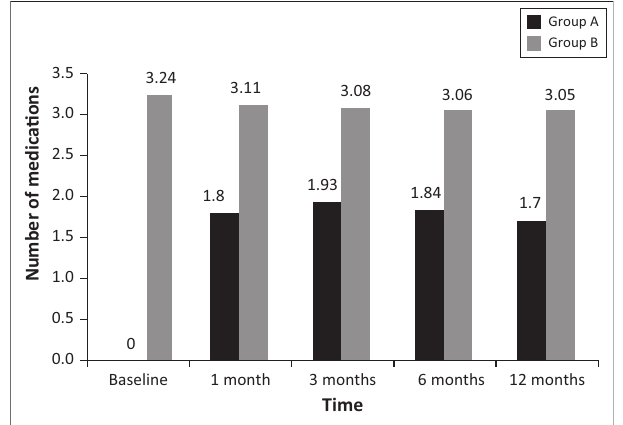
FIGURE 3: Number of medications needed after selective laser trabeculoplasty.